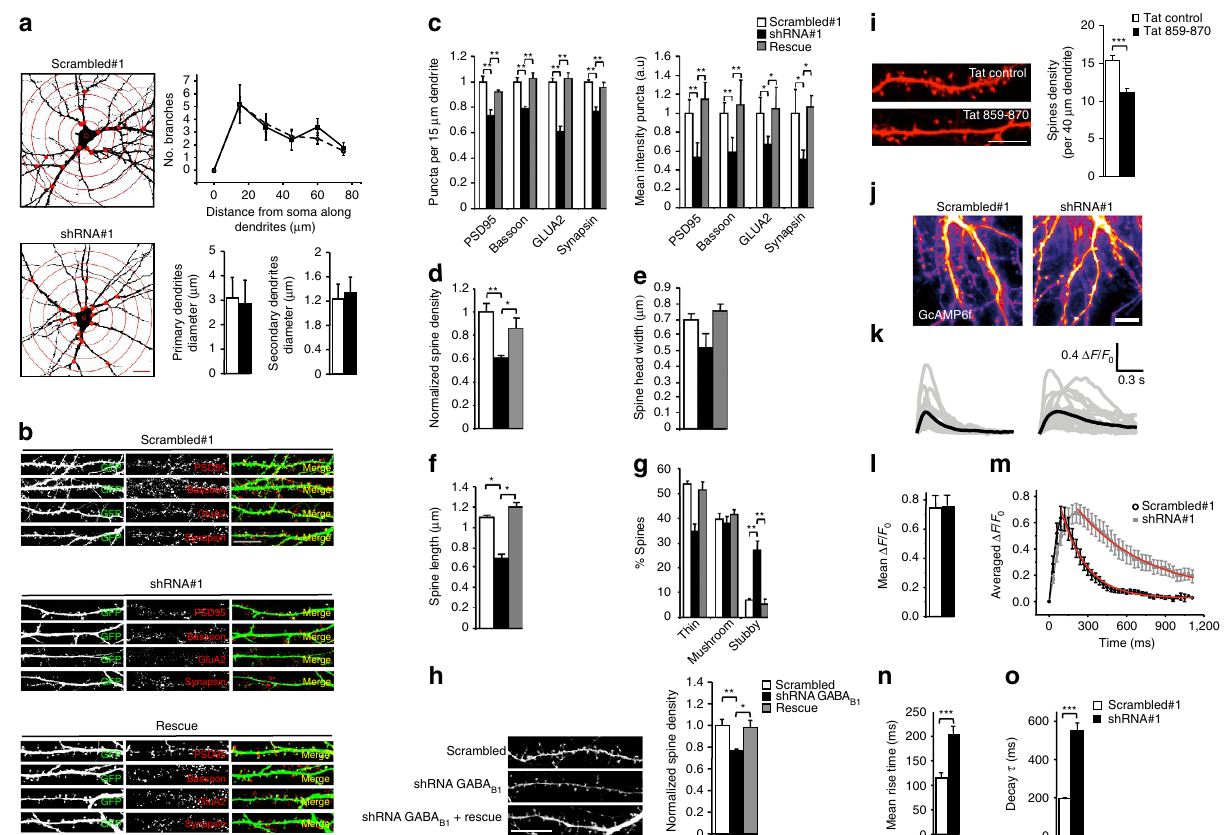
Figure 2 | Shrm4 is key mediator of dendritic spine formation and morphology. ( a ) Sholl analyses were performed on 18 DIV rat hippocampal neurons transfected at 8 DIV with GFP-coexpressing knockdown shRNA#1 or scrambled#1. No difference in dendritic arborization and diameter was observed between the two conditions. Scale bars, 10 m m. ( b ) Images of rat hippocampal neurons transfected at 8 DIV with Shrm4 scrambled#1, shRNA#1 or rescue constructs and immunostained for PSD-95, Bassoon, GluA2 and Synapsin post-synaptogenesis at 18 DIV . Scale bar, 10 m m. ( c ) Numbers of fluorescence puncta/15 m m dendrite (left panel) and mean fluorescence intensity of synaptic markers (right panel). The effect of Shrm4 silencing could be rescued by coexpressing wild-type Shrm4 cDNA resistant to knockdown by shRNA#1 (Data normalized to scrambled#1 controls) Histograms show mean ± s.e.m.; see Supplementary Table 2 for statistical tests. ( d ) Normalized spine density per 20 m m of hippocampal neurons transfected at 8 DIV for Shrm4 knockdown and rescue. See Supplementary Table 2 for statistical tests. ( e ) Spine head width and ( f ) length for scrambled, knockdown and rescue cells. See Supplementary Table 2 for statistical tests. ( g ) Percentages of mushroom, stubby and thin spines for scrambled, knockdown and rescue cells. Histograms show mean ± s.e.m.; see Supplementary Table 2 for statistical tests. ( h ) (Left) Images of rat hippocampal neurons transfected at 8 DIV with scrambled, GABA B1 knockdown shRNA or rescue constructs and analysed at 18 DIV . (Right) Histogram showing normalized spine density per 20 m m of hippocampal neurons transfected at 8 DIV for scrambled, GABA B1 knockdown and rescue; Histograms show mean ± s.e.m.; n ¼ 6–8 cells; Scrambled versus shRNA ** P ¼ 0.0056; shRNA versus rescue * P ¼ 0.0108, one-way ANOVA-Mann–Whitney. Scale bars, 10 m m. ( i ) (Left) Images of 17 DIV rat hippocampal neurons transfected at 5 DIV with pSuper and treated from 8 DIV to 13DIV with a Tat control or Tat-859–870 peptide. (Right) Histogram showing spine density per 40 m m dendrite of 17 DIV -treated hippocampal neurons; n ¼ 10; *** P ¼ 0.0001; t -test. Scale bar, 10 m m. ( j ) Representative Ca 2 þ signals from hippocampal neurons expressing dsRed-coexpressing knockdown shRNA#1 or scrambled#1 along with GCaMP6 fast under basal conditions in modified Krebs solution (in mM: 140 NaCl, 2.5 CaCl 2 , 4.7 KCl, 11 glucose, and 5 HEPES, pH 7.4. Scale bar, 5 m m. ( k ) Representative Ca 2 þ signals imaged from single dendrites (grey) and averaged traces (black) using GCaMP6f. ( l ) Maximum and averaged D F / F 0 values of Ca 2 þ signals in scrambled#1 and shRNA#1 condition. ( m ) Time course of averaged D F / F 0 values and single exponential fits (red) of Ca 2 þ signals in scrambled#1 and shRNA#1 condition. ( n ) Mean rise times and ( o ) decay t of Ca 2 þ signals in scrambled#1 and shRNA#1 condition n ¼ 10–15; histograms are means ± s.e.m. * P o 0.05, ** P o 0.01, *** P o 0.001; t -test.